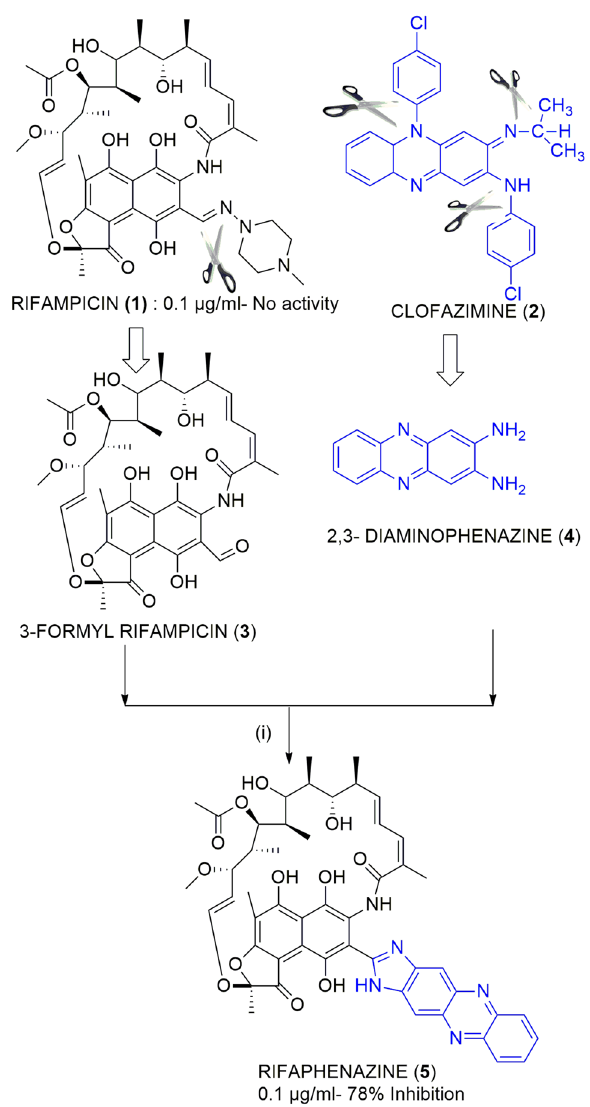
Figure 1. Synthesis of the hybrid molecule RPZ ( 5 ). Reagents and conditions: (i) Glacial acetic acid, MeOH, 45 ℃ , 2